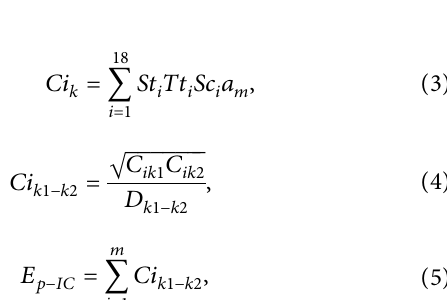
Figure 2: Lanzhou-Xining urban